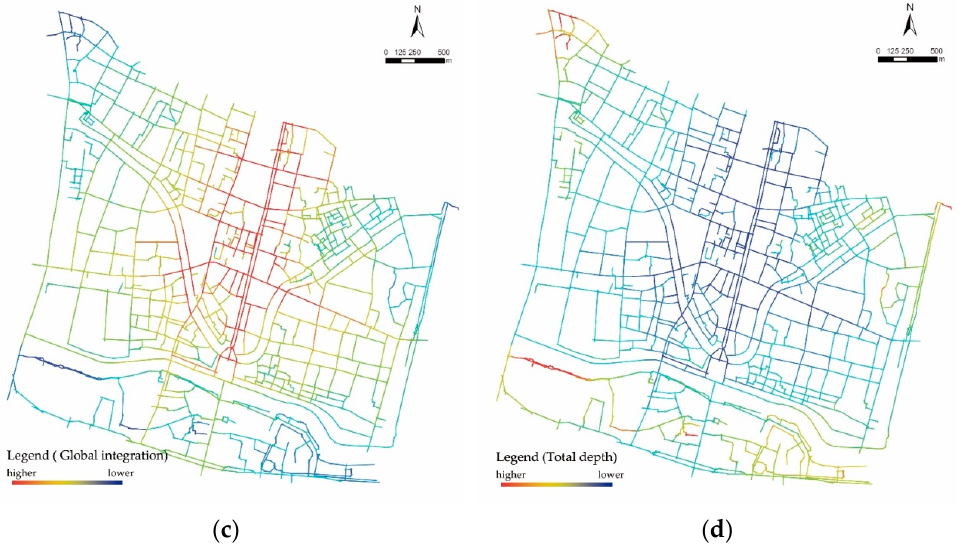
Figure 5. Axial map analysis: ( a ) connectivity value; ( b ) control value; ( c ) global integration value; ( d ) total depth value.